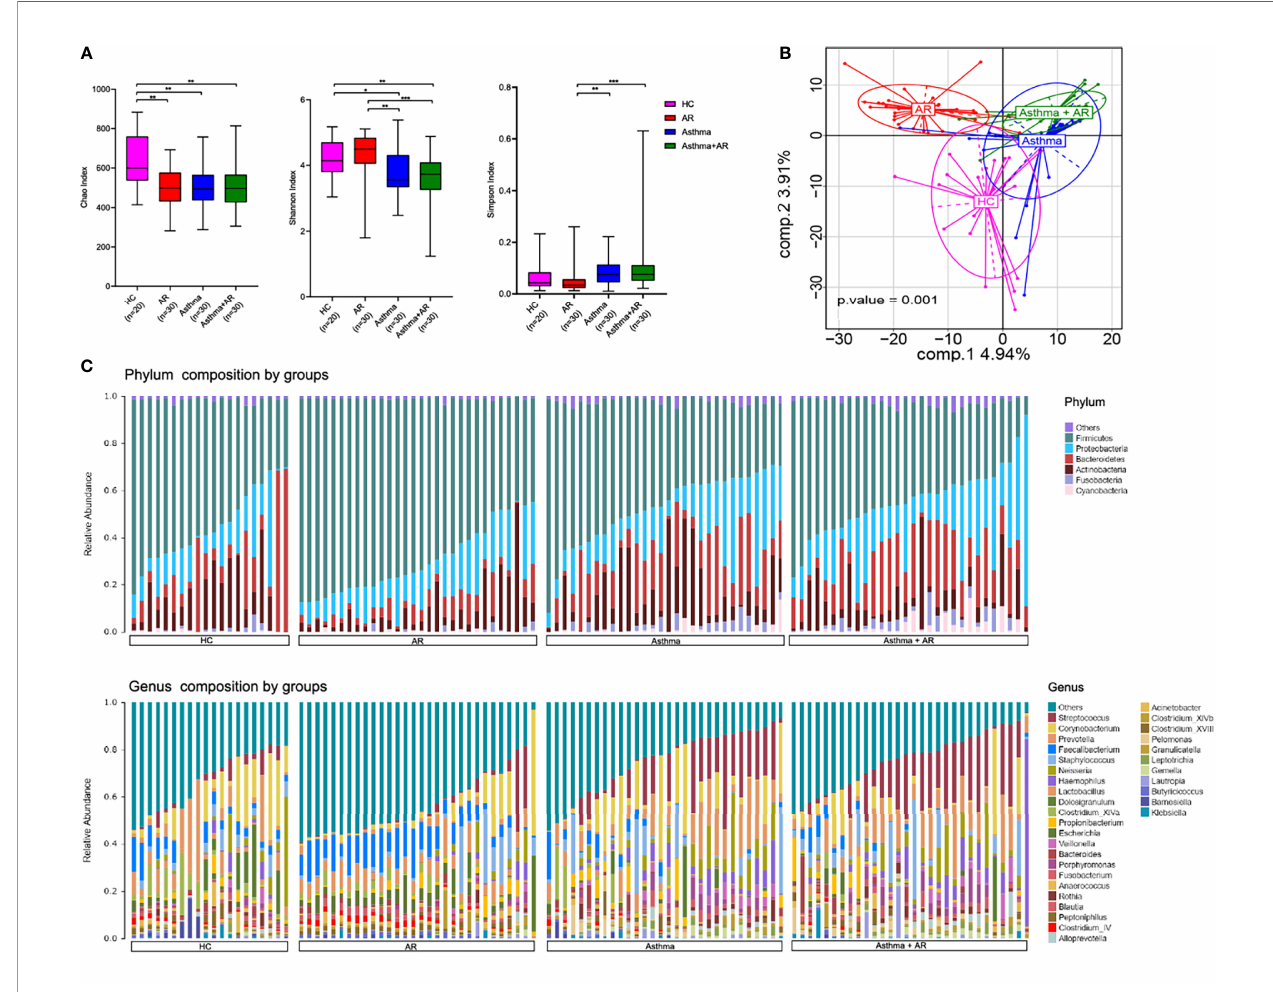
FIGURE 2 | The diversity and composition of the nasal microbiome vary among AR, asthma, combined asthma+AR and healthy controls. (A) Box plots of the a - diversity in AR, asthma, combined asthma+AR and healthy controls (Left plot, Chao index; middle plot, Shannon index; right plot, Simpson index). (B) Partial least squares discriminant analysis (PLS-DA) representing grouped microbiome pro fi le among AR, asthma, combined asthma+AR and healthy controls. (C) Bar plots of the phylum and genus taxonomic levels in AR, asthma, combined asthma+AR and healthy controls. P < 0.05 was considered as statistically signi fi cant, *P < 0.05, **P < 0.01, ***P <